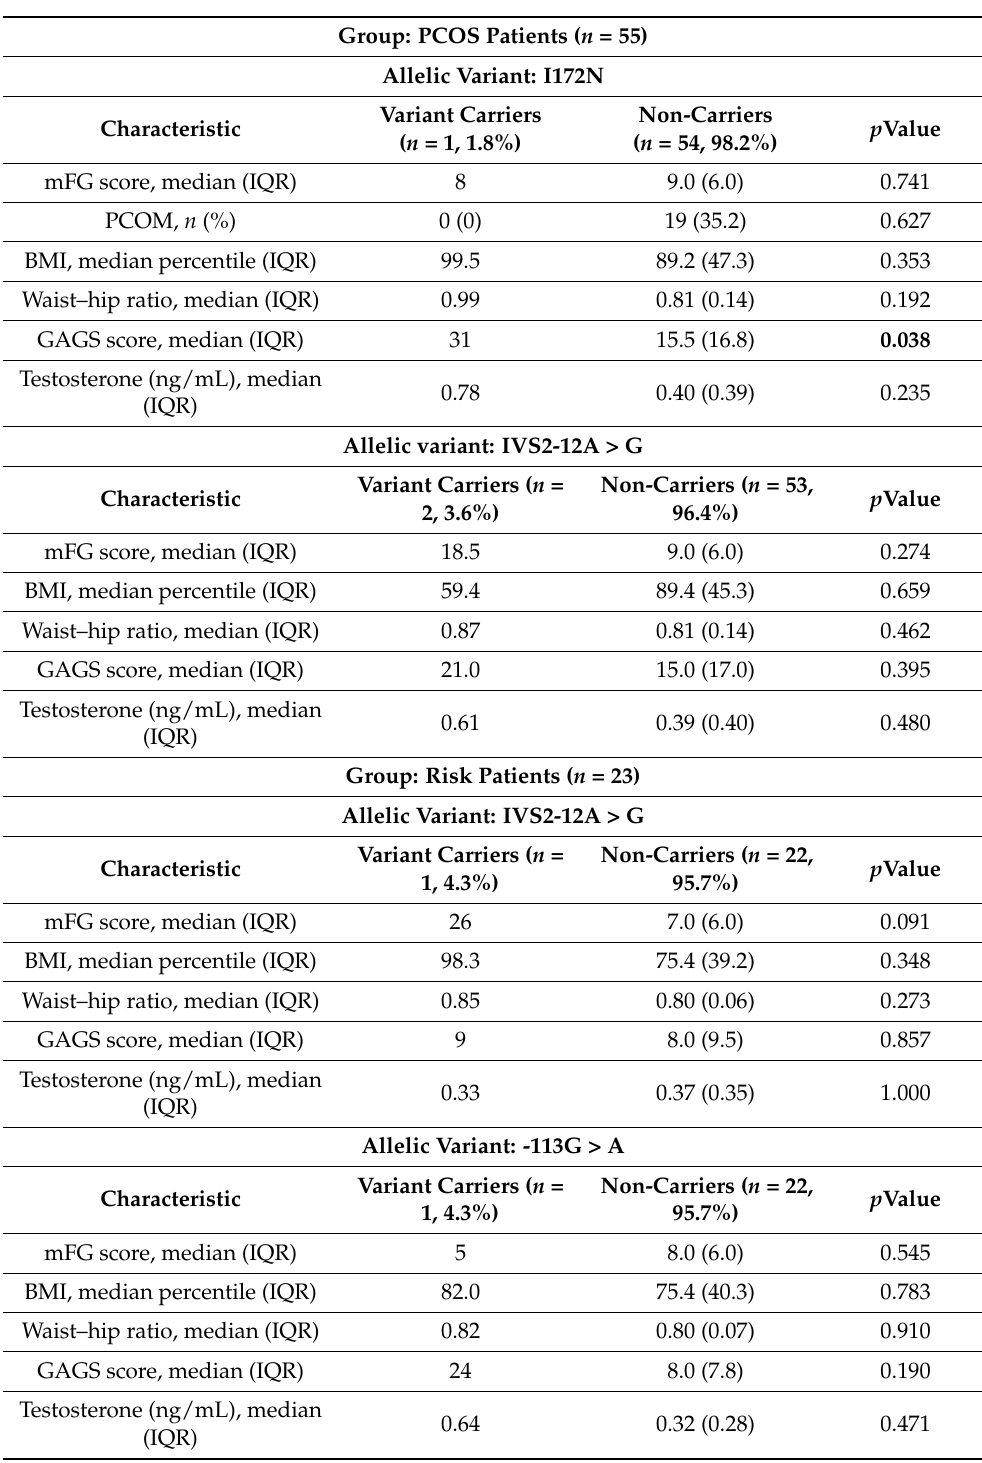
Table 4. Relationship between allelic variants and clinical